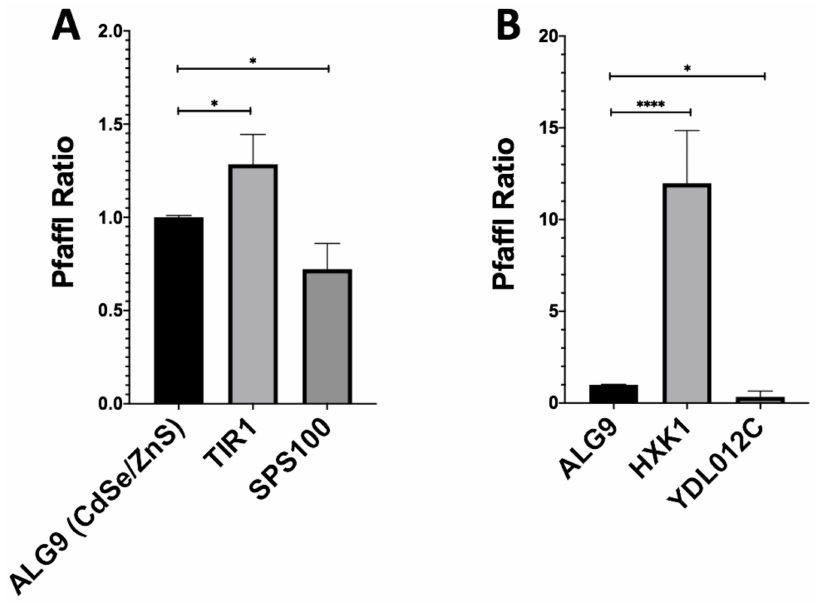
Figure 3. Gene expression ratios of ALG9 and one up- and downregulated gene from QD-treated samples determined by RT-qPCR. The reference gene ALG9 and other differentially expressed genes (from CdSe/ZnS and InP/ZnS-treated samples) were selected from our RNA-seq expression data and validated by determining their relative fold-change using the Pfaffl method. ( A ) Upregulated (TIR1) and downregulated (SPS100) genes with significantly altered gene expression levels Compared to ALG9 when treated with CdSe/ZnS. ( B ) Upregulated (HXK1) and downregulated (YDL012C) genes with significantly altered gene expression levels compared to ALG9 when treated with CdSe/ZnS. One asterisk (*) represents p < 0.05, while 4 asterisks (****) represent p <